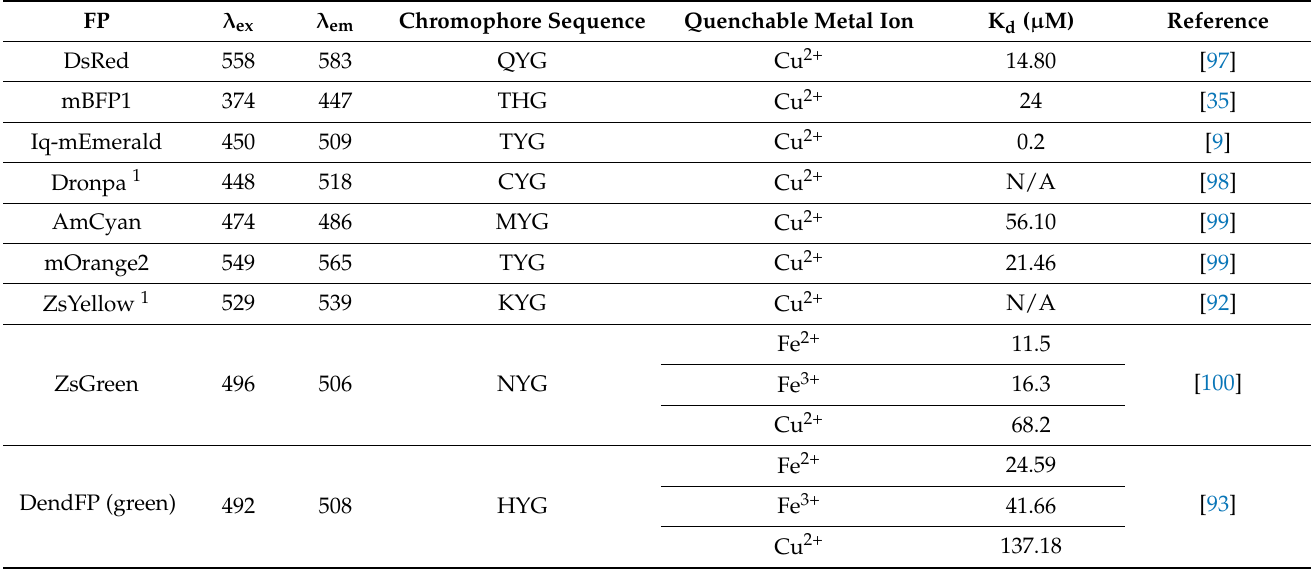
Table 4. Summary of characterized metal-induced fluorescence-quenched fluorescent proteins.